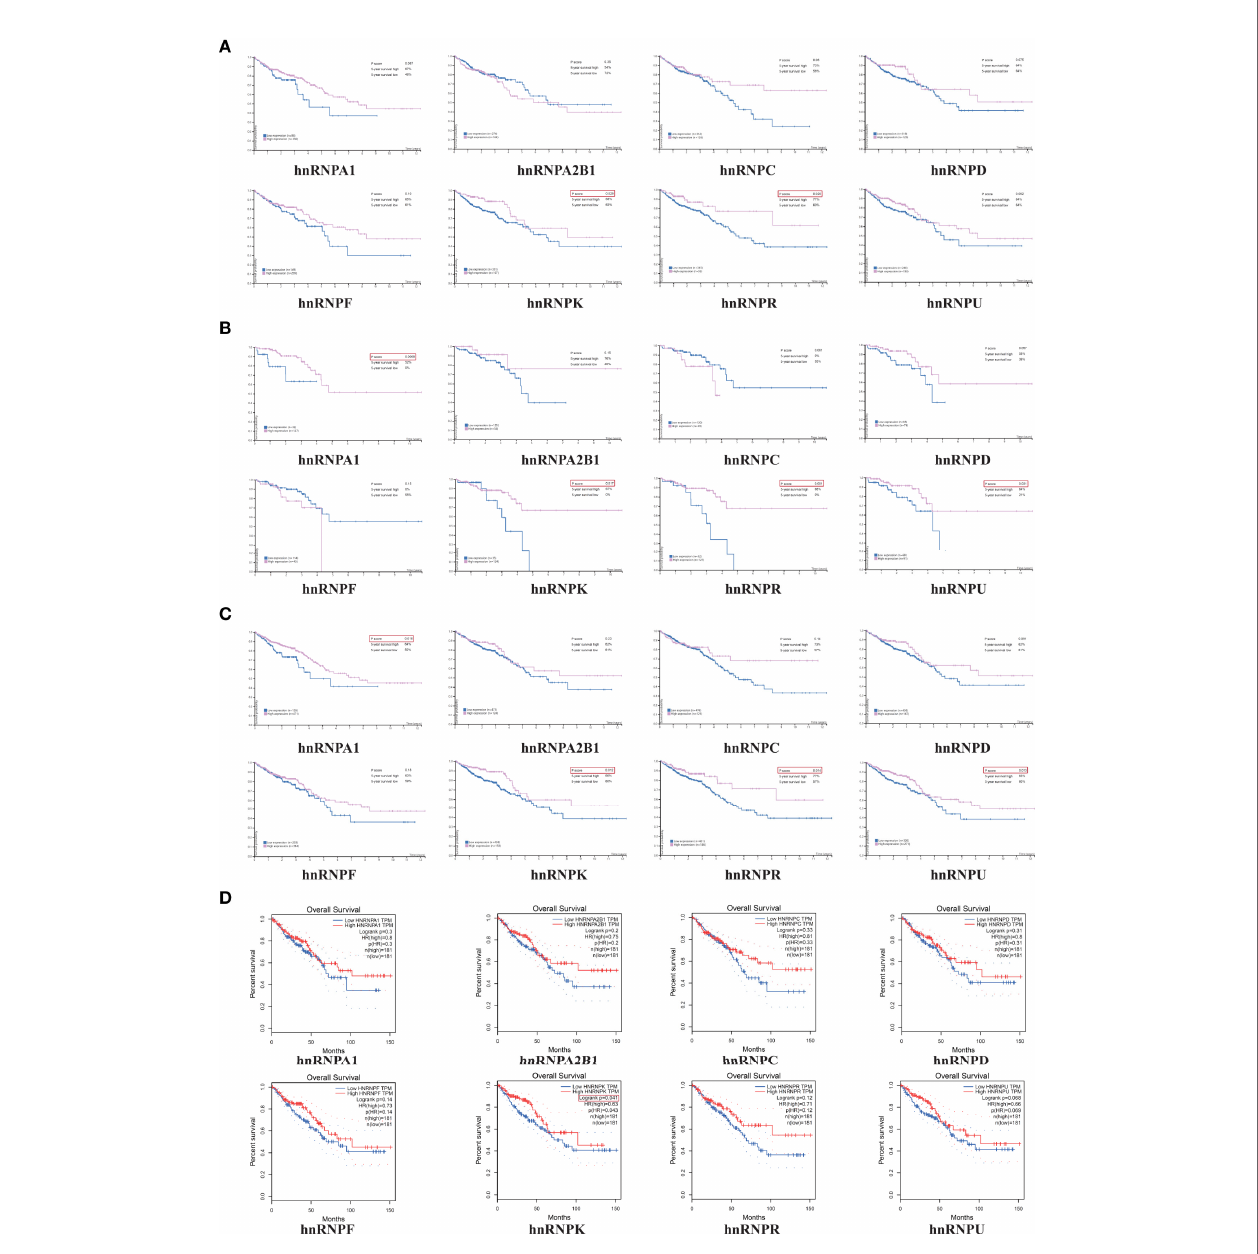
FIGURE 4 | High expressions levels of hnRNPA1, hnRNPK, hnRNPR, and hnRNPU were signi fi cantly associated with better OS rates in colorectal adenocarcinoma patients. (A) The HPA database was used to examine the relationship between the expression levels of hnRNPs and the survival rates of 597 patients with colorectal adenocarcinoma. The Kaplan-Meier survival analysis demonstrated that high expressions of hnRNPK and hnRNPR were signi fi cantly associated with better OS rates for COAD patients. (B) High expressions of hnRNPA1, hnRNPK, hnRNPR, and hnRNPU were signi fi cantly associated with better OS rates for READ patients. (C) High expressions of hnRNPA1, hnRNPK, hnRNPR, and hnRNPU were signi fi cantly associated with better OS rates for colorectal adenocarcinoma patients. (D) The GEPIA database was selected to further examine the survival of 181 COAD patients and 181 READ patients. Similarly, high expression of hnRNPK was associated with better OS results showed that transcription, translation, and ribosomal large associated with the hnRNPK/A1/R/U network ( Figure 5A ). subunit assembly were signi fi cantly regulated by the hnRNPK/A1/ Additionally, the GEPIA webtool revealed that the TPM levels of R/U alterations in colorectal adenocarcinoma ( Figure 5C ). hnRNPK/A1/R/U with each other were positively correlated Furthermore, ribosomal subunit, nucleotide binding, structure ( Figure 5B ). The functional predictions of hnRNPK/A1/R/U constituent of ribosome, and poly(A) RNA-binding were also network were analyzed in the DAVID webtool. The GO analysis